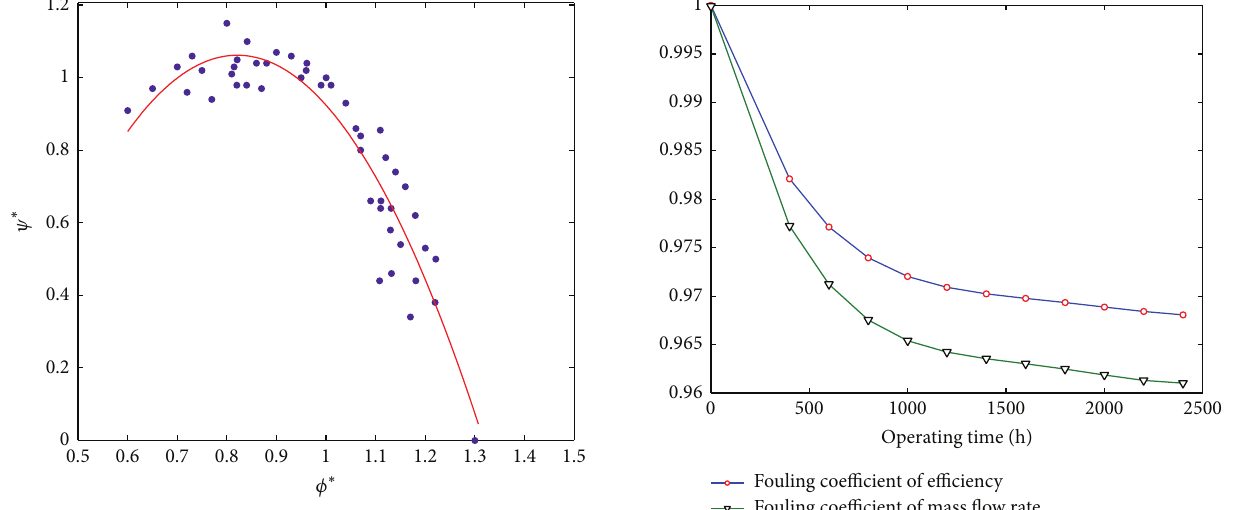
Figure 2: Generalized stage pressure coefficient curve.